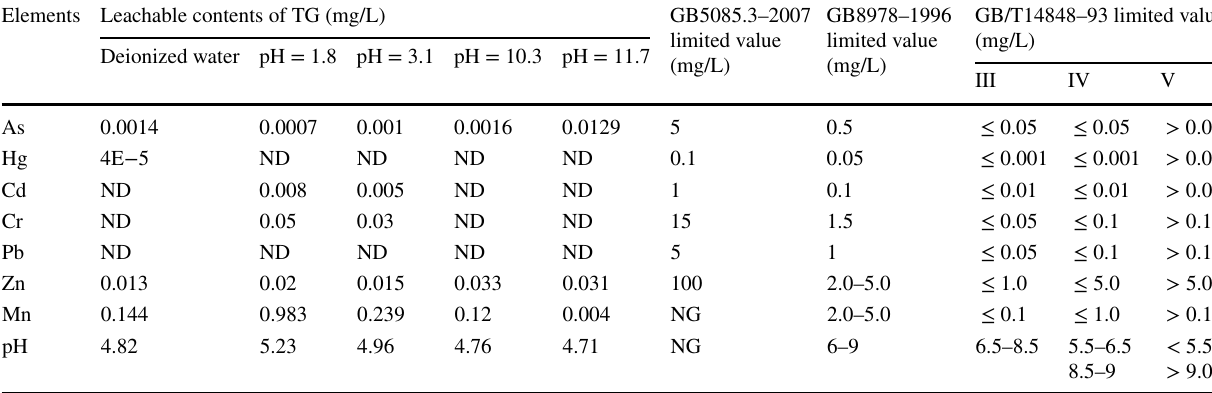
“ND” represents “not detected”; “NG” represents “not Table 5 Comparison between leachable contents of the elements in TG gypsum and national environmental quality standard limits for hazardous pollutants